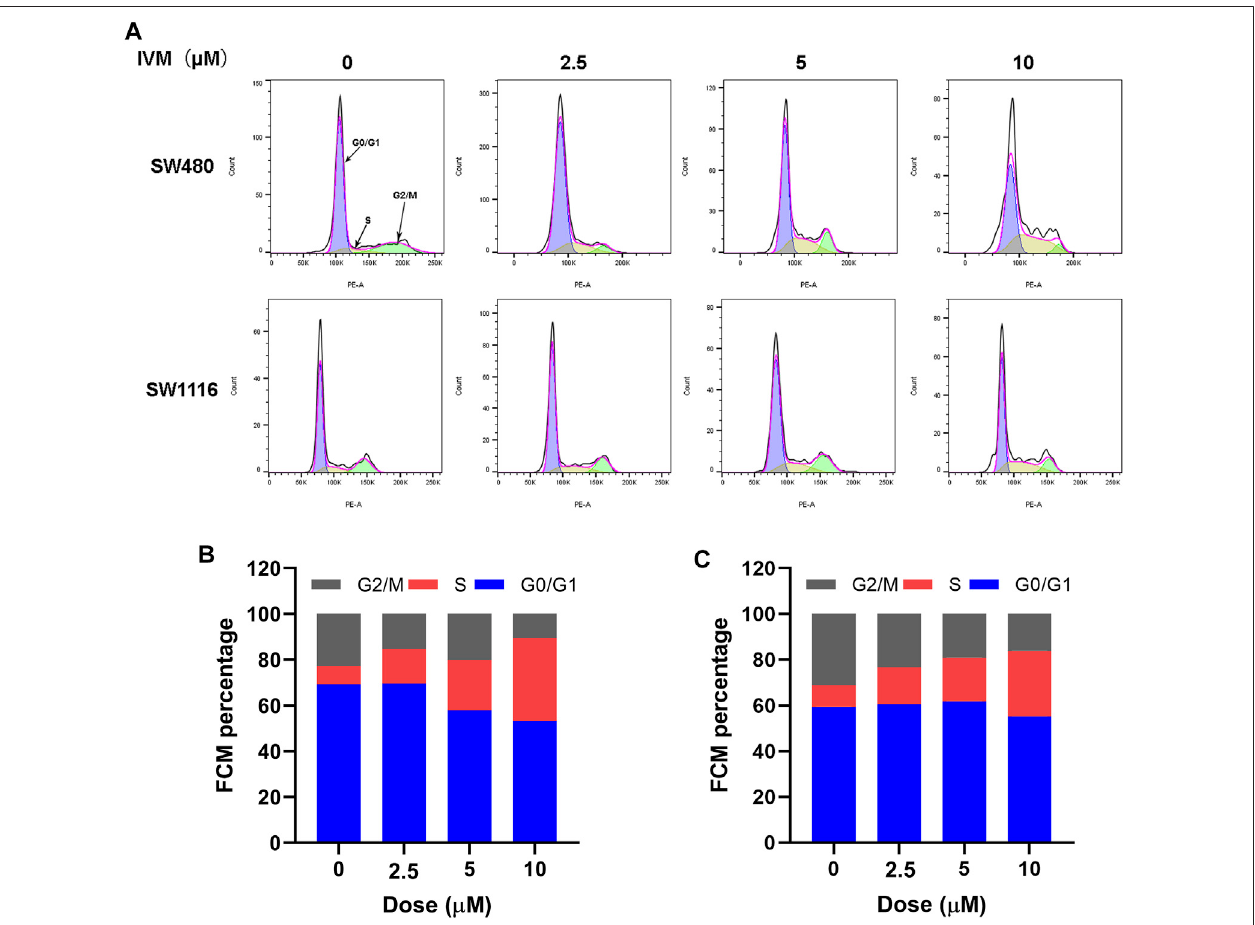
FIGURE 10 | Ivermectin resulted in S-phase cell cycle arrest in a dose-dependent manner in colorectal cancer cells. (A) Different concentrations of ivermectin (0, 2.5, 5, 10, and 20 μ M) were applied to SW480 and SW1116 cells for 12 h; fl ow cytometry was used to detect cell cycle changes. Representative cell cycle histograms were shown in (A) , and analysis of periodic distribution statistical results was shown in (B) and (C) . IVM, ivermectin.